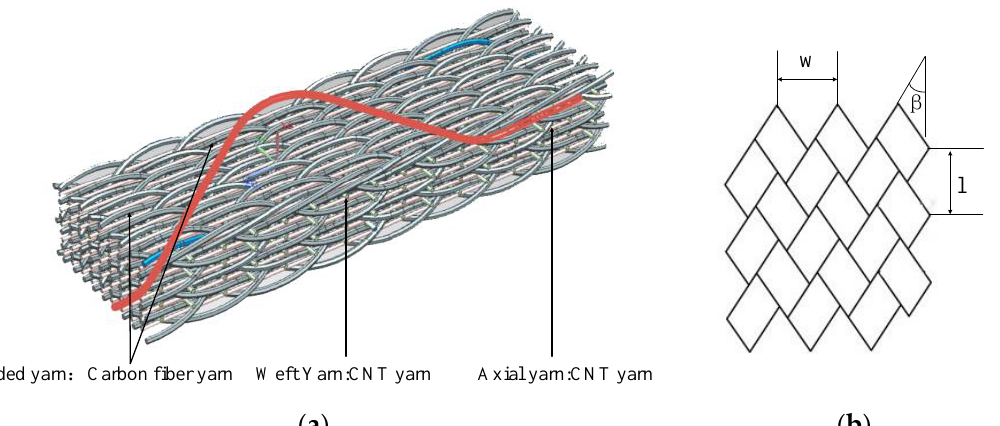
Figure 2. The 3D six-direction braided preform embedded with CNT yarn sensor: ( a ) The distribution of CNT in the preform; ( b ) the surface of the preform.